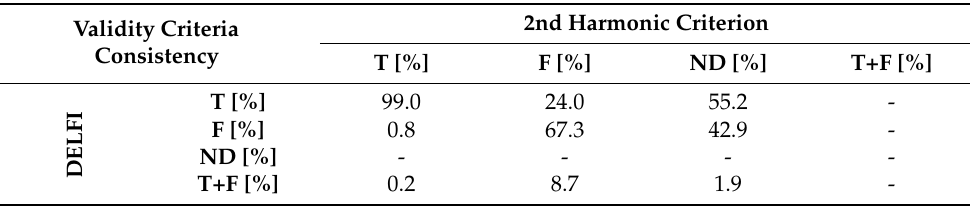
Table 2. Validity assessment: criteria consistency expressed in percent values with respect to the 2nd harmonic